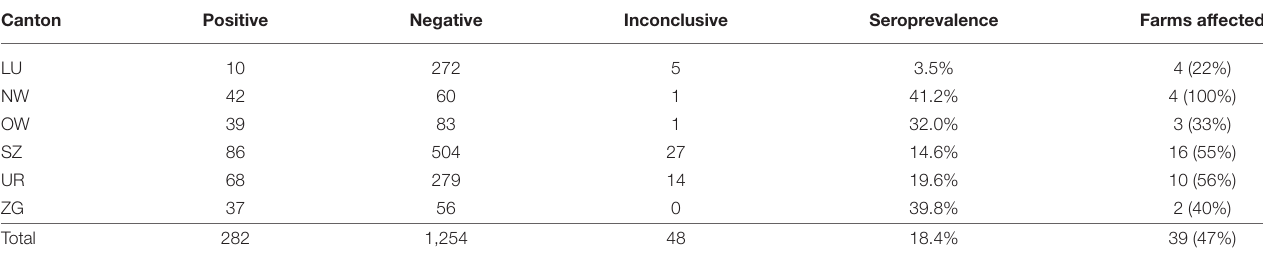
TABLE 3 | Pestivirus seroprevalence and number of farms harbouring seropositive animals (“farms affected”) per canton according to the ELISA results of sheep sera collected in 2001. Canton Positive Negative Inconclusive Seroprevalence Farms affected SZ 262 928 UR Total 267 949 Samples with inconclusive ELISA results were omitted from the calculation of the seroprevalence. TABLE 4 | Pestivirus seroprevalence and number of farms harbouring seropositive animals (“farms affected”) according to the ELISA results of sheep sera collected in 2016–2017. Canton Positive Negative Inconclusive